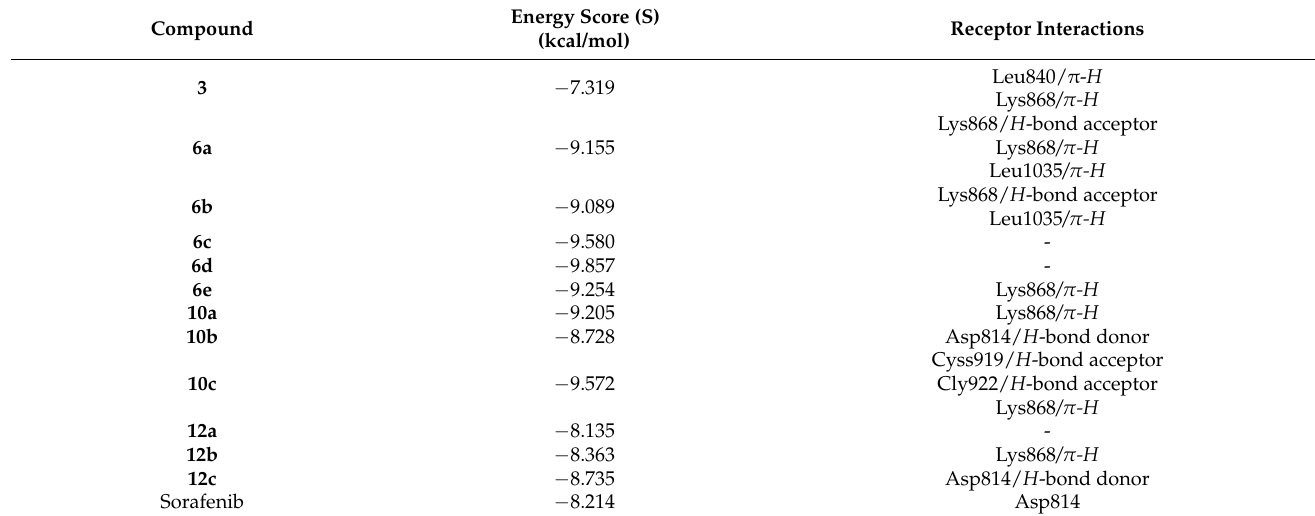
Table 2. Energy scores and receptor interactions of active VEGFR-2 with DFG-in motif for the synthesized compounds ( 3 , 6a–e , 10a–c and 12a–c ), compared to Sorafenib.